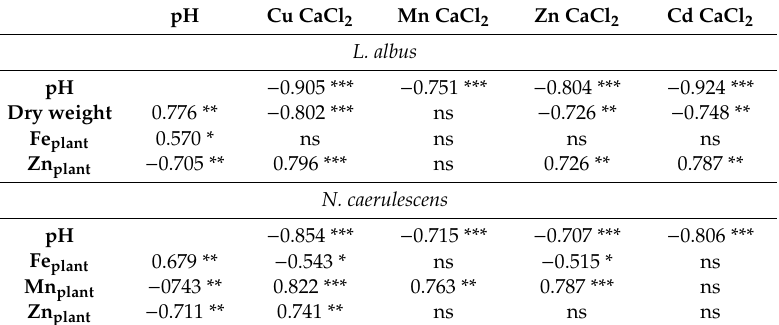
Table 6. Correlation matrix between the soil characteristics and the biomass and metal concentrations in the plants ( L. albus and N. caerulescens ) from Experiment